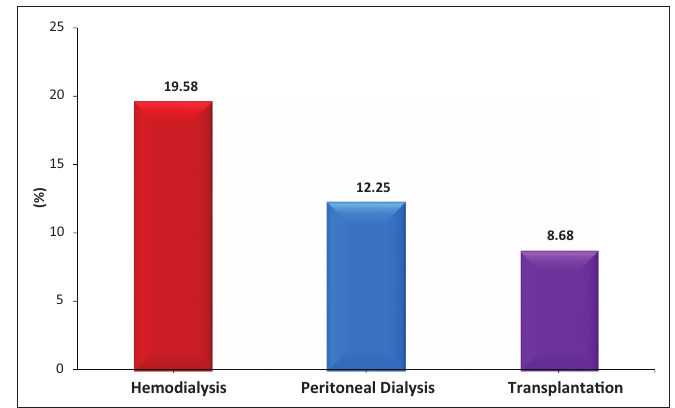
Figure 1. Coronavirus disease 2019 frequency in kidney replacement therapy modalities.